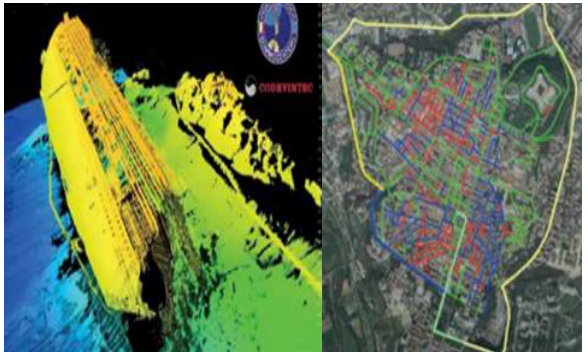
Figure 2. a) Three-dimensional scan of the Costa Concordia ship; b) Cartographic elaboration of the traffic of the center of L'Aquila during the 2009 earthquake